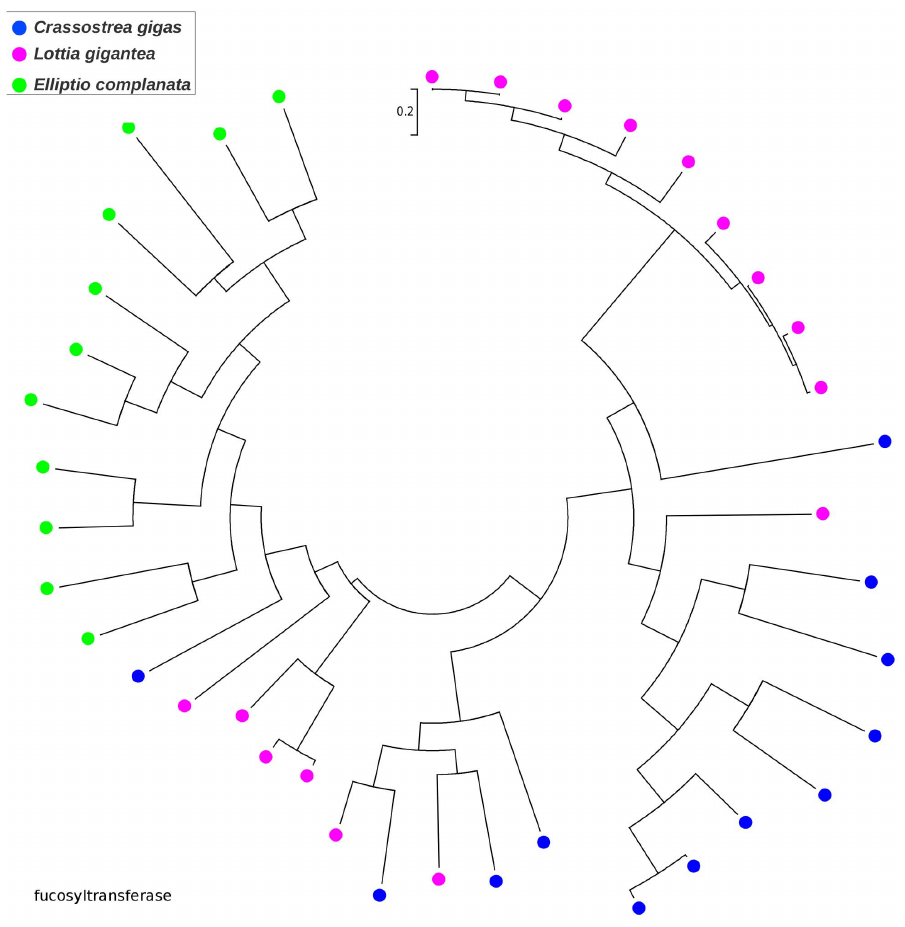
Figure 4. Gene tree of fucosyltransferase sequences from Elliptiocomplanata and two other molluscs suggesting lineage-specific diversification. Trees were rendered in MEGA5 [16] using maximum likelihood and the JTT amino-acid substitution matrix. Bootstrap support was not evaluated because no explicit phylogenetic hypothesis was tested. Multiple-sequence alignment with gene/contig names is provided in fasta format in the supplemental materials.